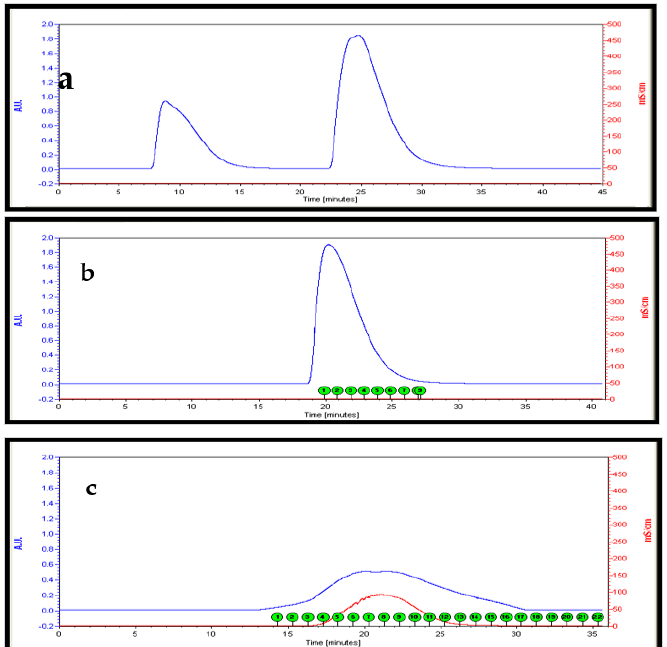
Figure-1. ( a ) Elution profiles of crude alkaline protease ( b ) elution profiles of ammonium sulphate precipitates ( c ) elution profile of